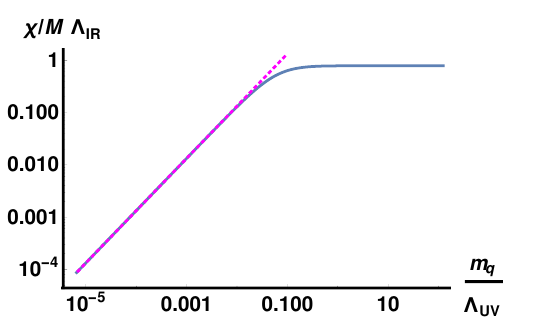
Figure 1. The dependence of the topological susceptibility on the quark mass in the “standard”, dominant vacuum at x = 2 / 3 and ¯ θ = 0. The blue solid curve is the results for V-QCD and the dashed magenta curve is the prediction from chiral Lagrangians at small m q